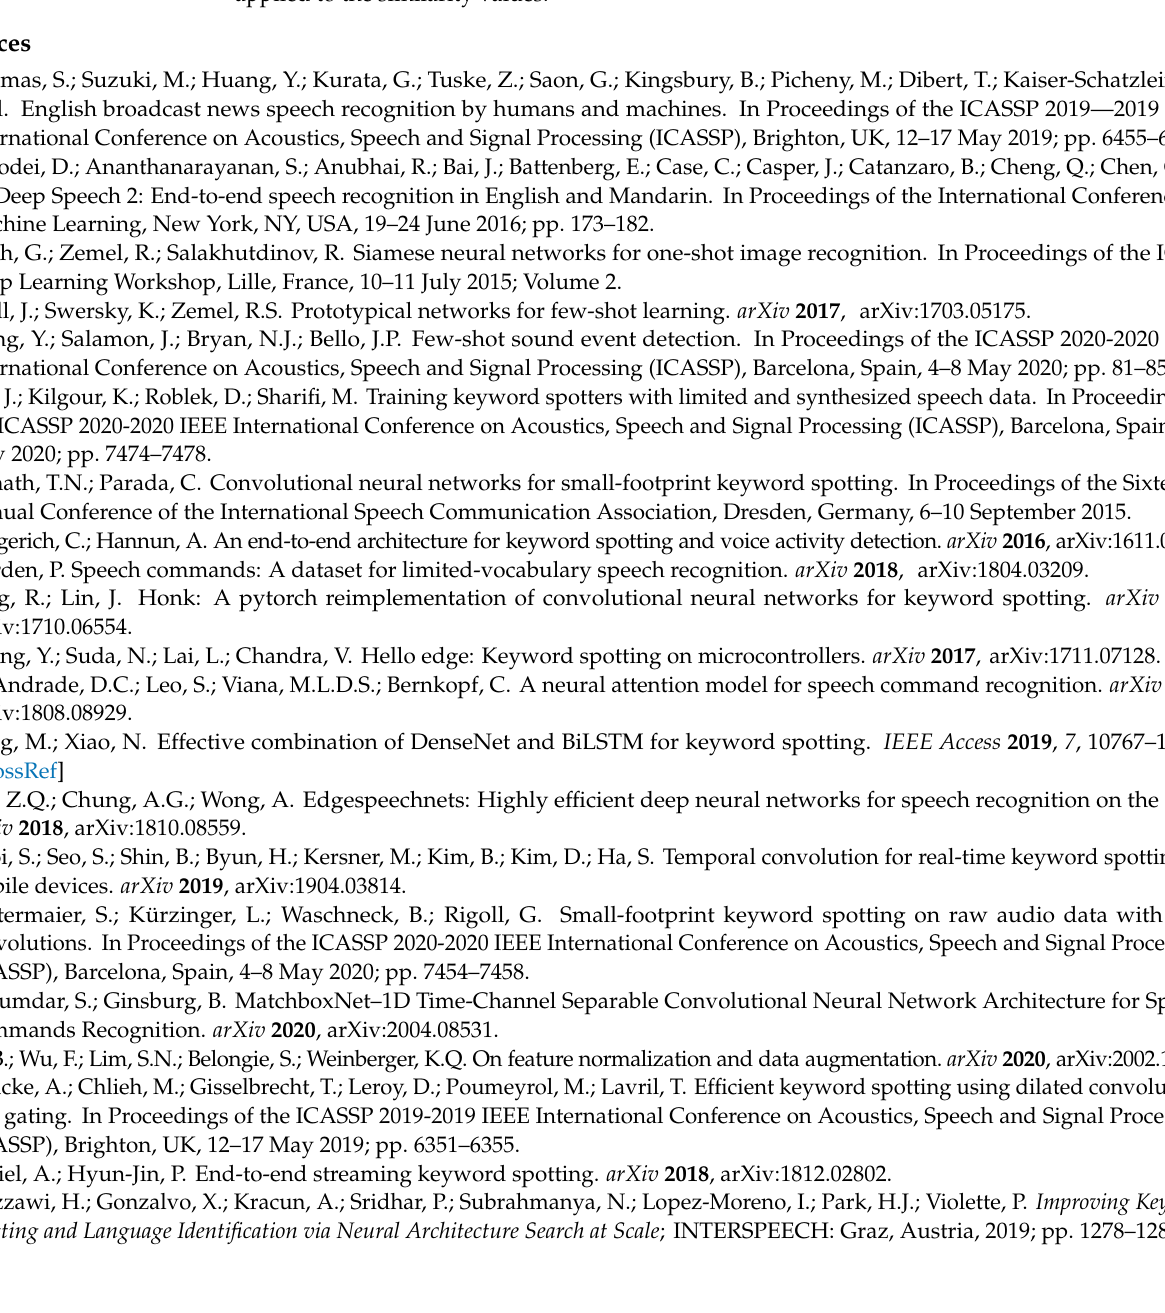
Figure A2. Same detection report for the Google speech embedding model, with post-processing applied to the similarity